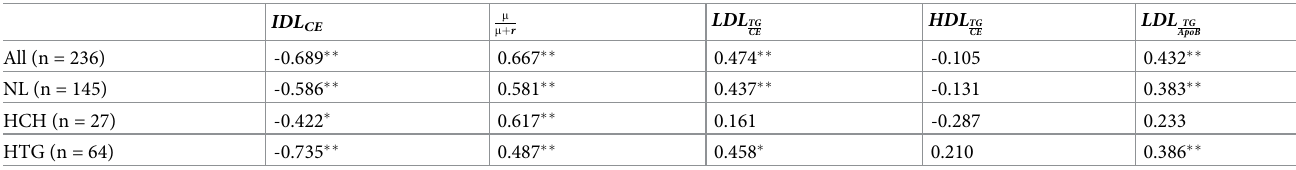
Table 3. Comparison of correlations associated with 1/ LDL